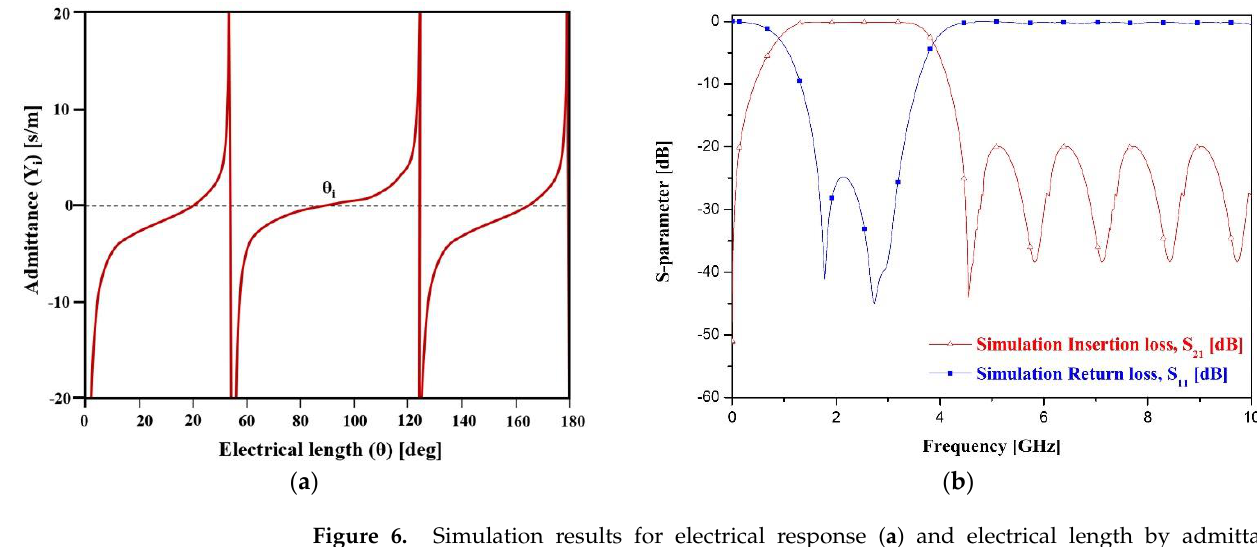
Figure 6. Simulation results for electrical response ( a ) and electrical length by admittance ( b ) band-